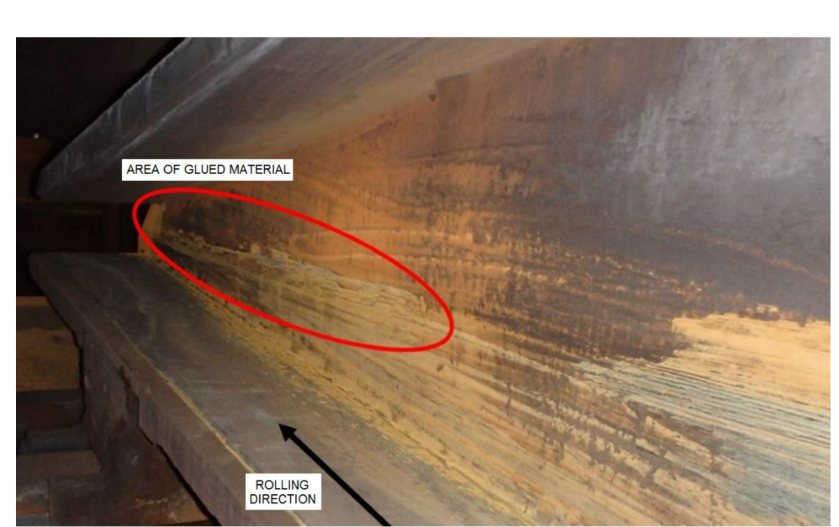
Figure 4. Glued material on guide rulers. Source: own